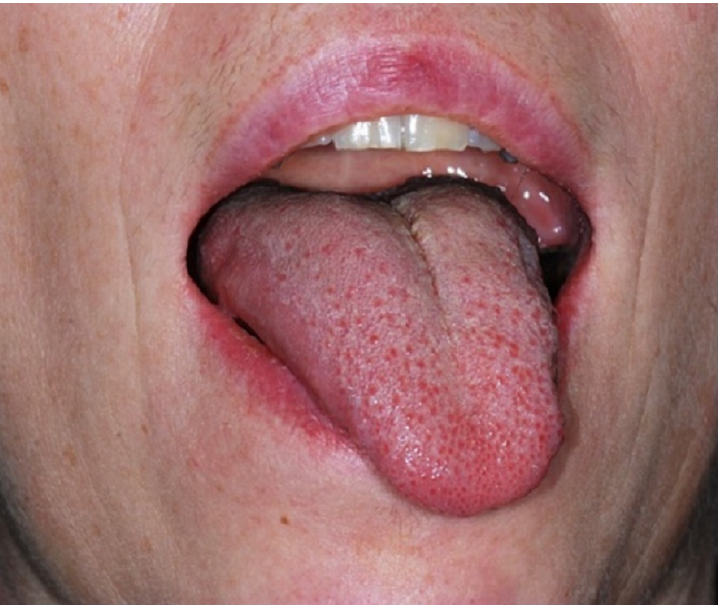
Figure 1. The initial clinical investigation shows a marked deviation of the tongue to the left as the typical feature of a left ‐ sided hypoglossal nerve